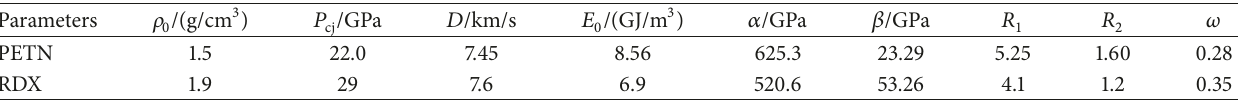
Figure 8: Microcosmic characteristic of fracture. Table 2: Parameters of